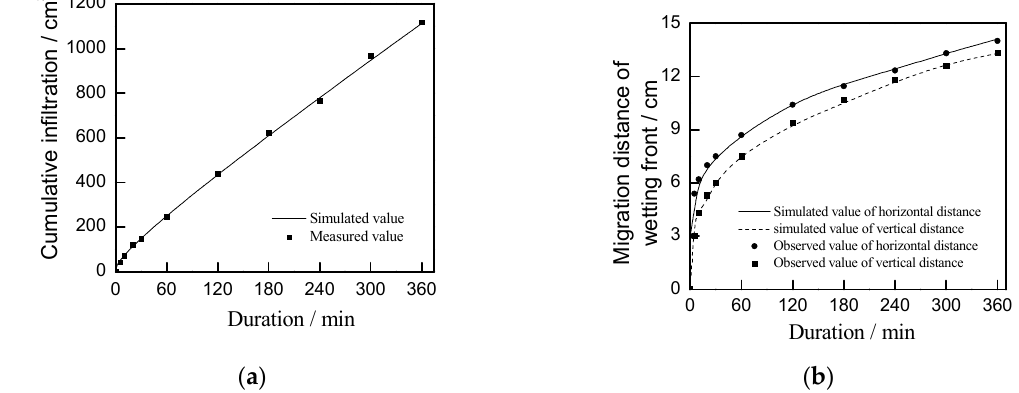
Simulated value of horizontal distance simulated value of vertical distance Observed value of horizontal distance Observed value of vertical distance